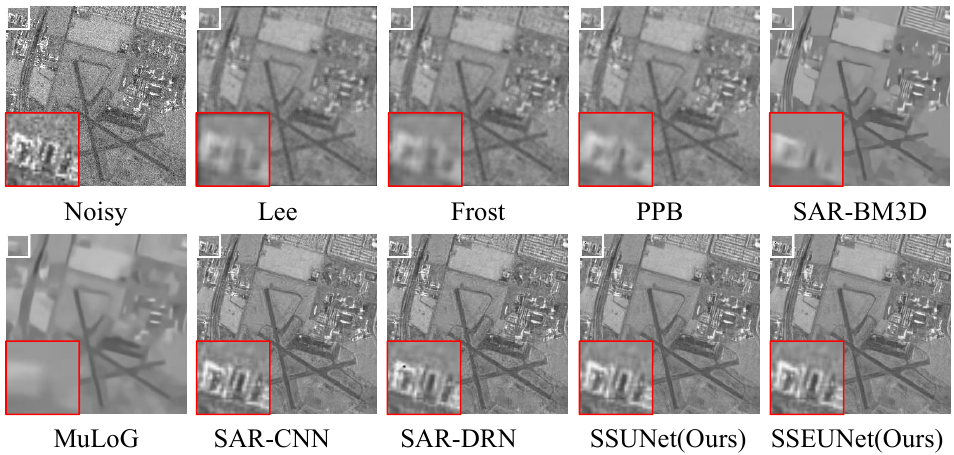
Figure 12. Visual results of heterogeneous regions on real-word SAR images.